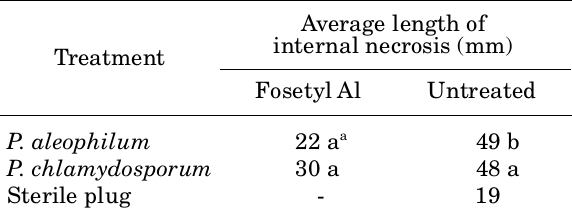
Table 2. Activity of fosetyl Al foliar applications against Phaeoacremonium